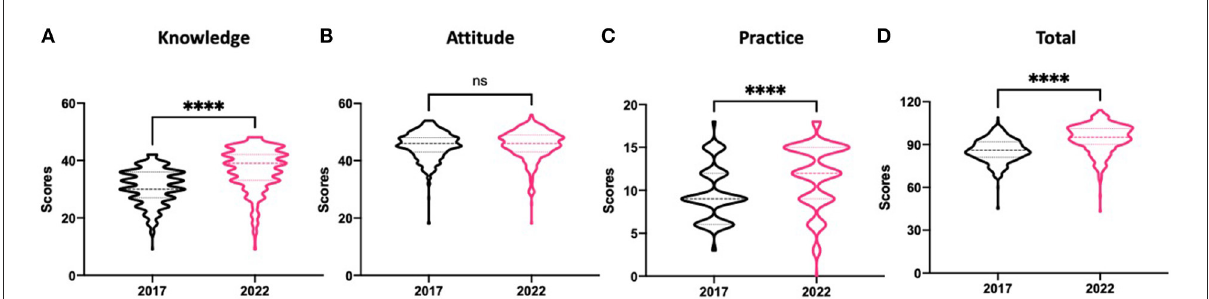
FIGURE1 The grading graphs of respondents’ knowledge, attitude, and practice on antimicrobials. Scores were calculated according to the grading standards and statistical test by Mann–Whitney with p -value < 0.001 (****) was considered statistically significant. Significances were observed in the scores of knowledge, practices and total respondents. (A) Knowledge scores were calculated based on the questions in Table 2A. Significances were observed among the respondents between 2017 and 2022 ( p < 0.001). (B) Attitude scores were analyzed by evaluating the questions in Tables 2B and 3. No differences were found between the two groups ( p = 0.2805). (C) Practice scores were computed based on the questions in Table 2C with significant differences detected ( p < 0.001). (D) Total scores were statistically counted according to all the questions in Tables 2 and 3. Significances were observed among the two groups with regard to antimicrobial resistance ( p <